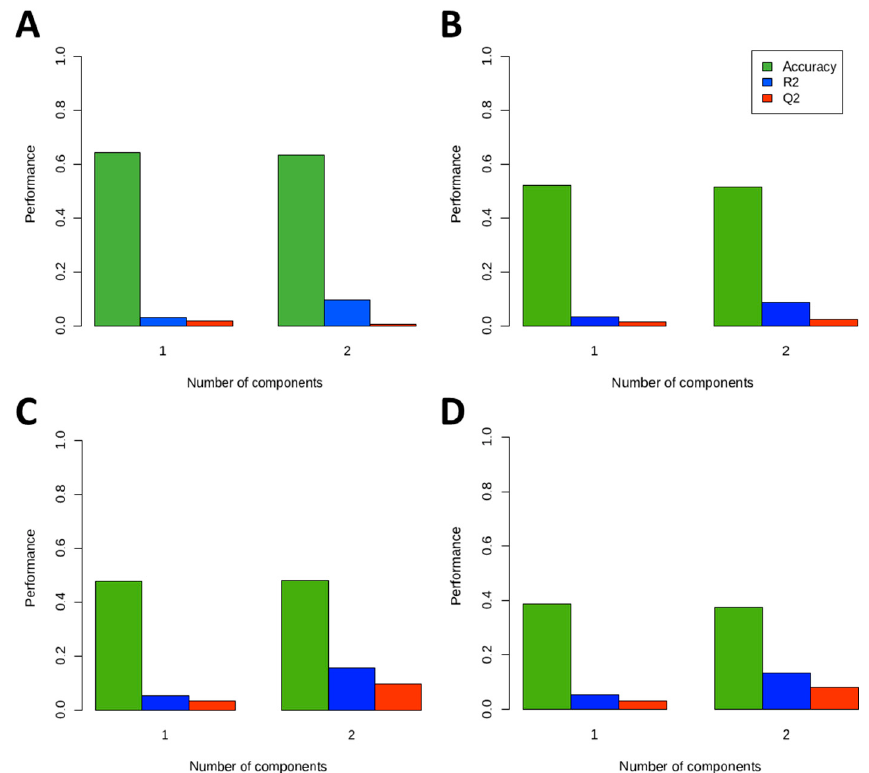
Figure A1. The explained variances. ( A ) MetS status (accuracy 0.63; R2 0.096; Q2 0.027); ( B ) MetS status and age (accuracy 0.51; R2 0.086; Q2 0.040); ( C ) MetS status and sex (accuracy 0.48; R2 0.155; Q2 0.086); ( D ) MetS, sex, and age (accuracy 0.375; R2 0.133; Q2 0.081).